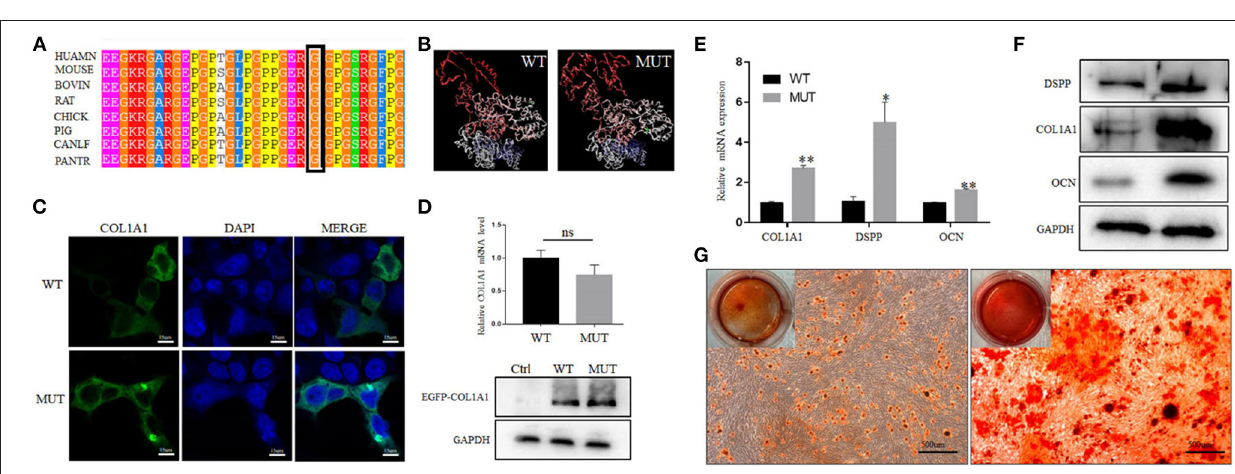
FIGURE 4 | Effect of the mutation on COL1A1 function. (A) Conservation analysis of this abnormal variation using Polyphen-2. (B) The 3D structure of mutated COL1A1 was different from that of the wild-type (WT) predicted structure using I-TASSER. (C) Subcellular localization of COL1A1 in HEK293 cells. The mutant COL1A1 was localized in the cytoplasm similar to the WT protein. (D) The mRNA and protein expression levels of COL1A1 in HEK293 cells. Mutant COL1A1 mRNA expression was no different than that of the WT in HEK293 cells, but the mutant COL1A1 protein expression was higher than that of the WT ( P < 0.05). (E,F) Analysis of the mRNA and protein expression of COL1A1 and odontogenic differentiation markers (DSPP and OCN) during the osteogenic differentiation of hDPSCs. Values are represented as means ± SD of three independent experiments (* P < 0.05 and ** P < 0.01). (G) Representative images from the ARS staining of DPSCs-MUT and DPSCs-CON at the indicated time points after differentiation